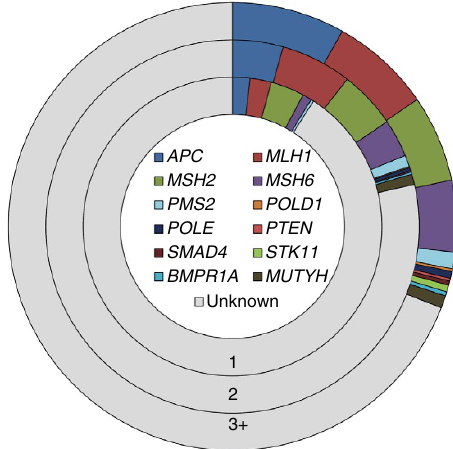
Figure 3 | Contribution of rare mutations in known predisposition genes to familial CRC applying three different variant classifications. (1) Class 1, disruptive; (2) Class 2, predicted damaging; (3) Class 3, all non- synonymous variants, and in addition, splice region variants catalogued as pathogenic by InSight or Clinvar.